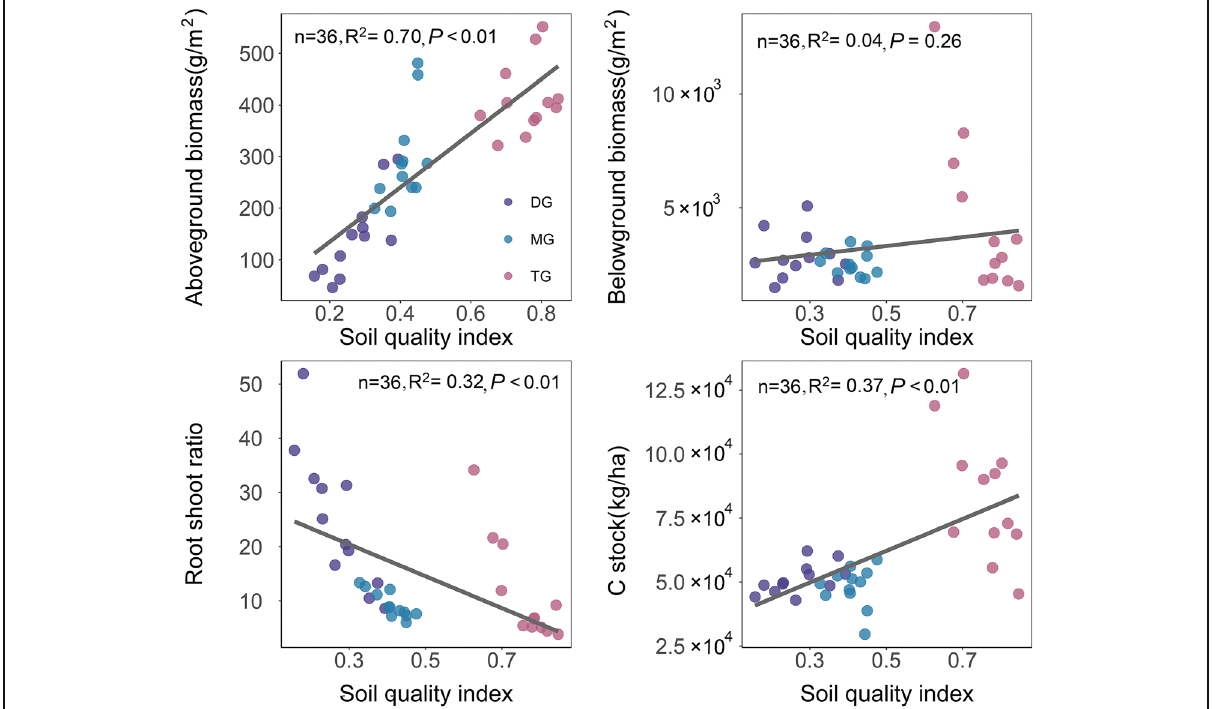
Fig. 4 Correlations between soil quality index and selected soil and plant